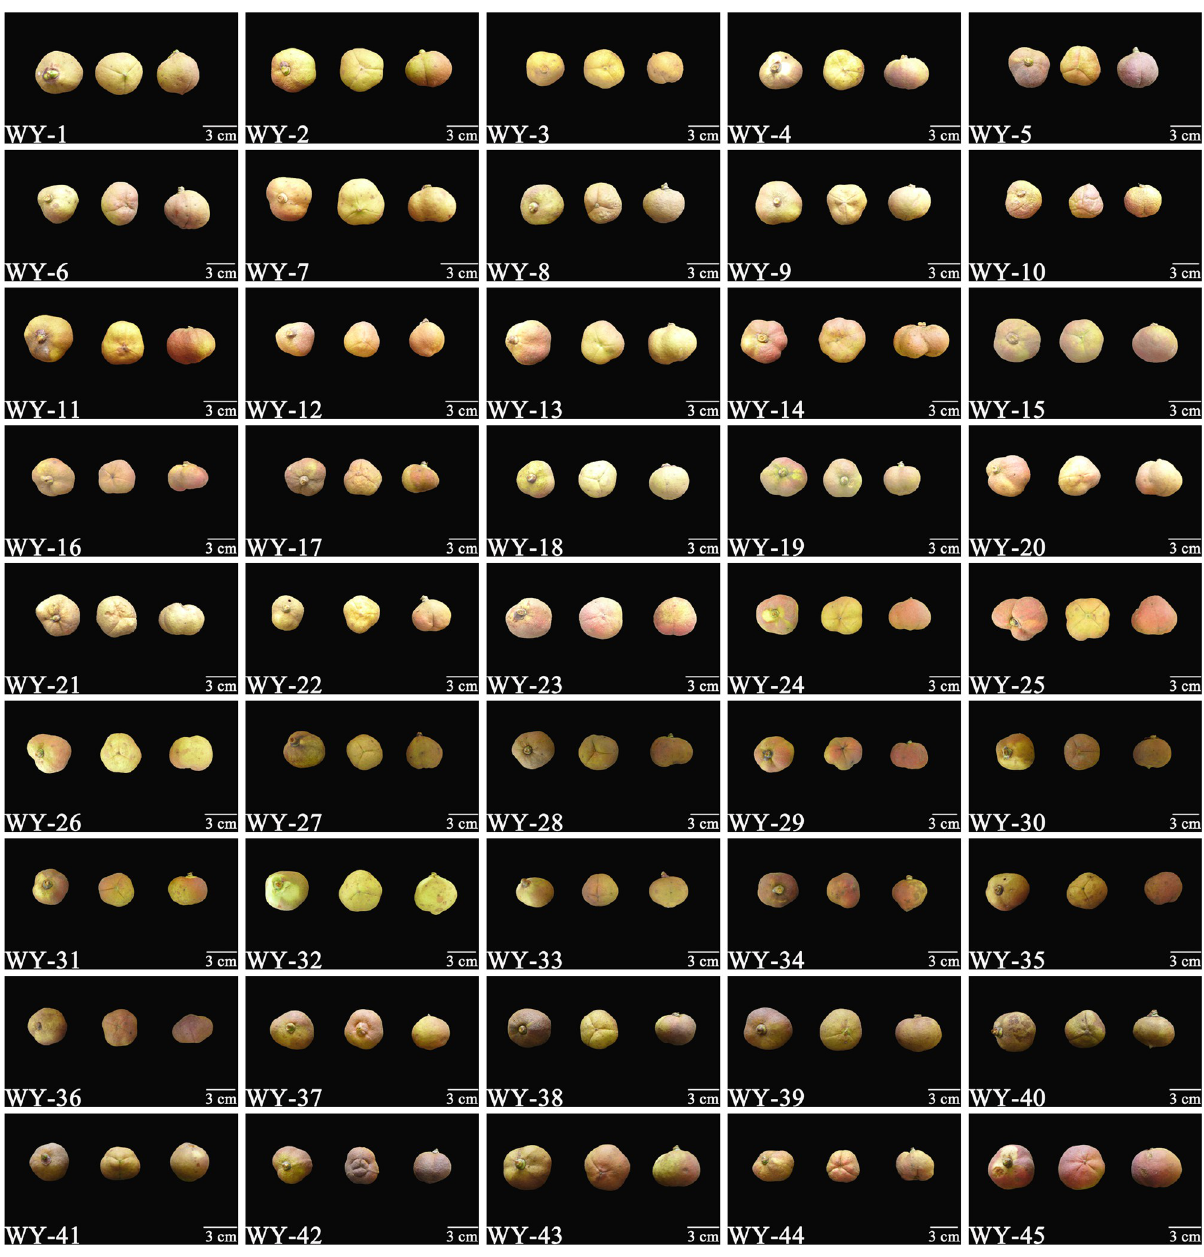
Fig 1. Fruit of 45 superior C . weiningensis plants (polar and equatorial views). Photos of three randomly selected mature fruits from the same tree. Two show the polar view, and one shows the equatorial view. The lower left corner of each panel provides the plant ID no., and the lower right corner indicates the scale (3